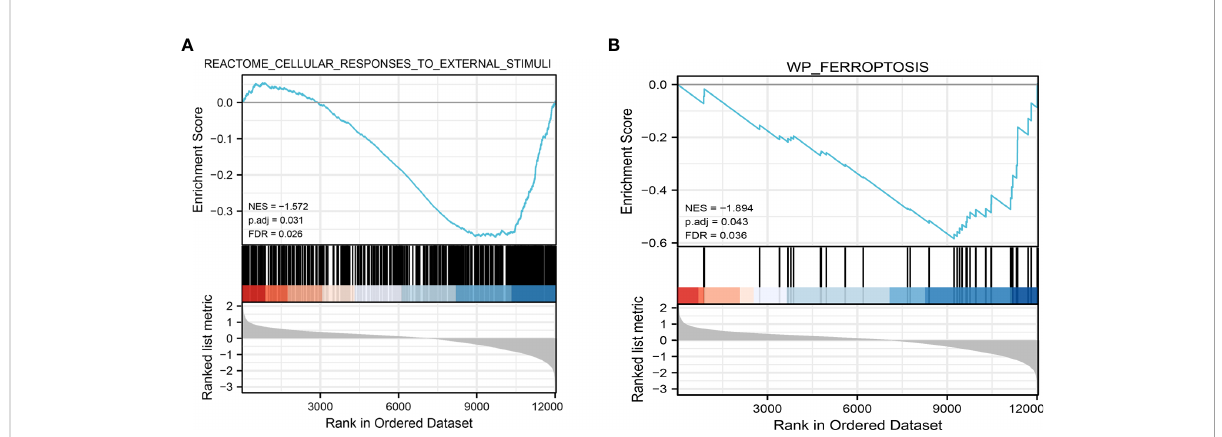
FIGURE 2 Representative results of GSEA analysis in the gene expression data in GSE25724. (A) The most signi fi cant enriched gene set negatively correlated with the T2D group was cellular responses to external stimuli (NES = -1.572, p.adj=0.031, FDR =0.026). (B) The ferroptosis-related gene set was negatively correlated with the T2D group (NES = -1.894, p.adj=0.041, FDR =0.036). NES, normalized enrichment